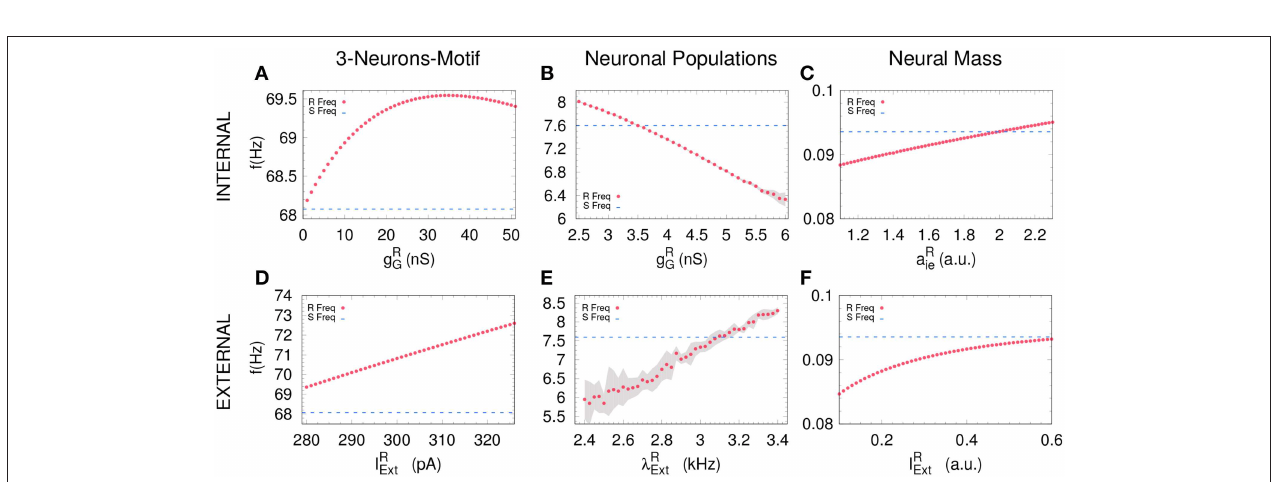
FIGURE 2 | Assessing anticipated and delayed synchronization in cortical motifs. For all the models—3-neurons-motif (left), neuronal populations (middle) and neural masses (right)—a transition from delayed synchronization (DS, τ > 0, cyan dots) to anticipated synchronization (AS, τ < 0, yellow dots) is possible increasing the inhibition in the receiver (A–C) ; or increasing the external stimulus (D–F) . Gray shadow represents the standard deviation over 10 runs (see Methods). For the parameters used here see Methods.